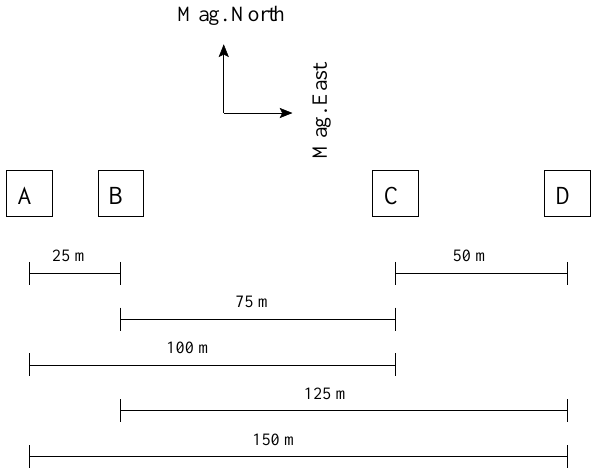
Fig. 1. Diagram showing the disposition of the four (A, B, C and D) antenna modules. The modules are aligned in the magnetic east- west